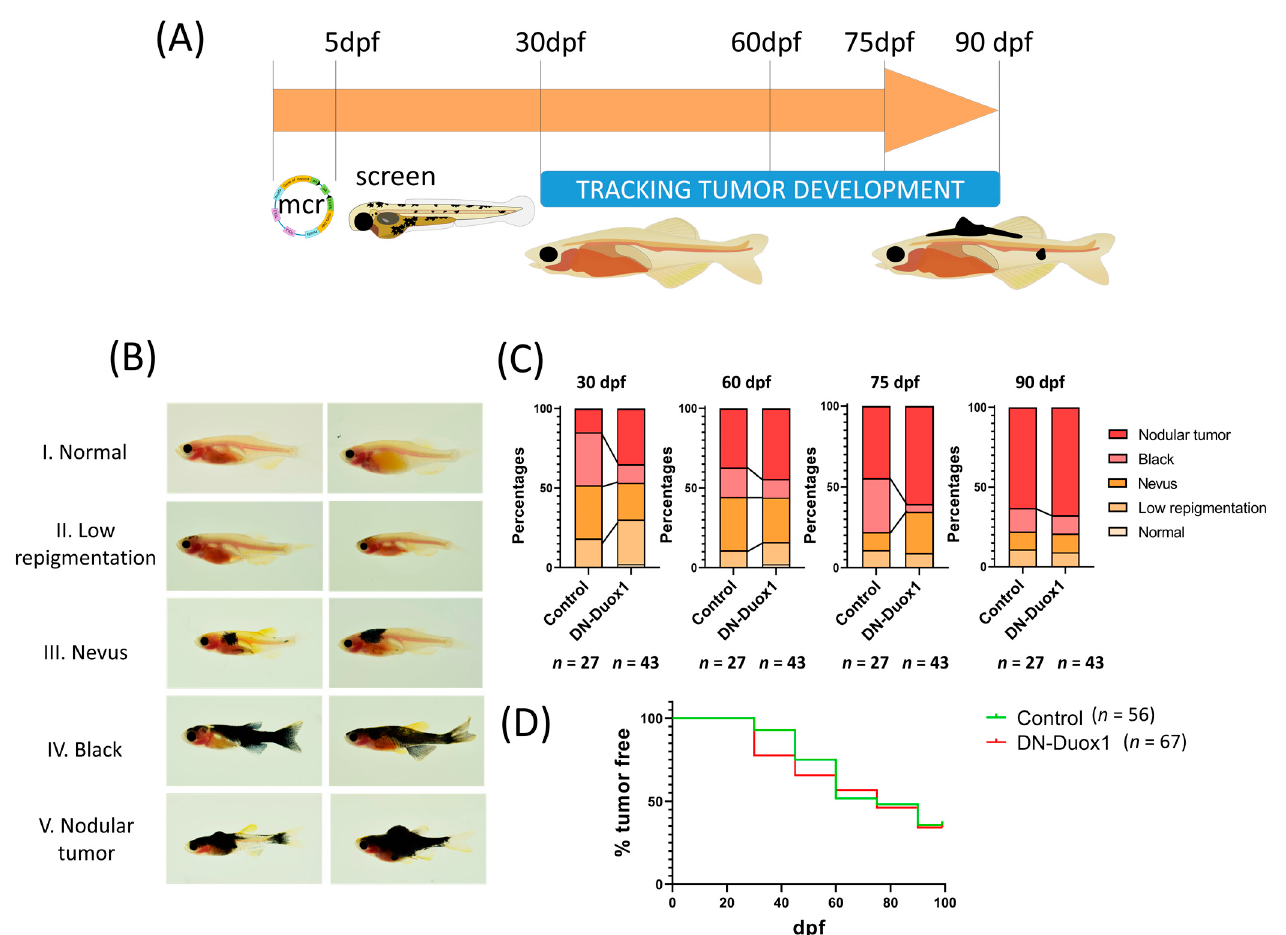
Figure 2. Melanocyte DUOX1 inhibition does not affect melanocyte transformation and early melanoma progression. ( A ) Schematic representation of the procedure to co-express oncogenic NRAS-Q61R and DN-DUOX1 in melanocytes. Zebrafish one-cell Casper zebrafish embryos were injected with MinicoopR mitfa:NRAS-Q61R and either MinicoopR mitfa:DN-DUOX1 or MinicoopR mitfa:EGFP (control). Larvae were examined at 5 dpf for the presence of melanocytes and images were acquired monthly for 3 months to track melanoma development. ( B ) Representative images of the five different categories established to classify tumor progression. ( C ) Percentages of fish in the different categories at 30, 60, 75 and 90 dpf. ( D ) Tumor free curve. Representation of the percentage of fish without nodular tumors.